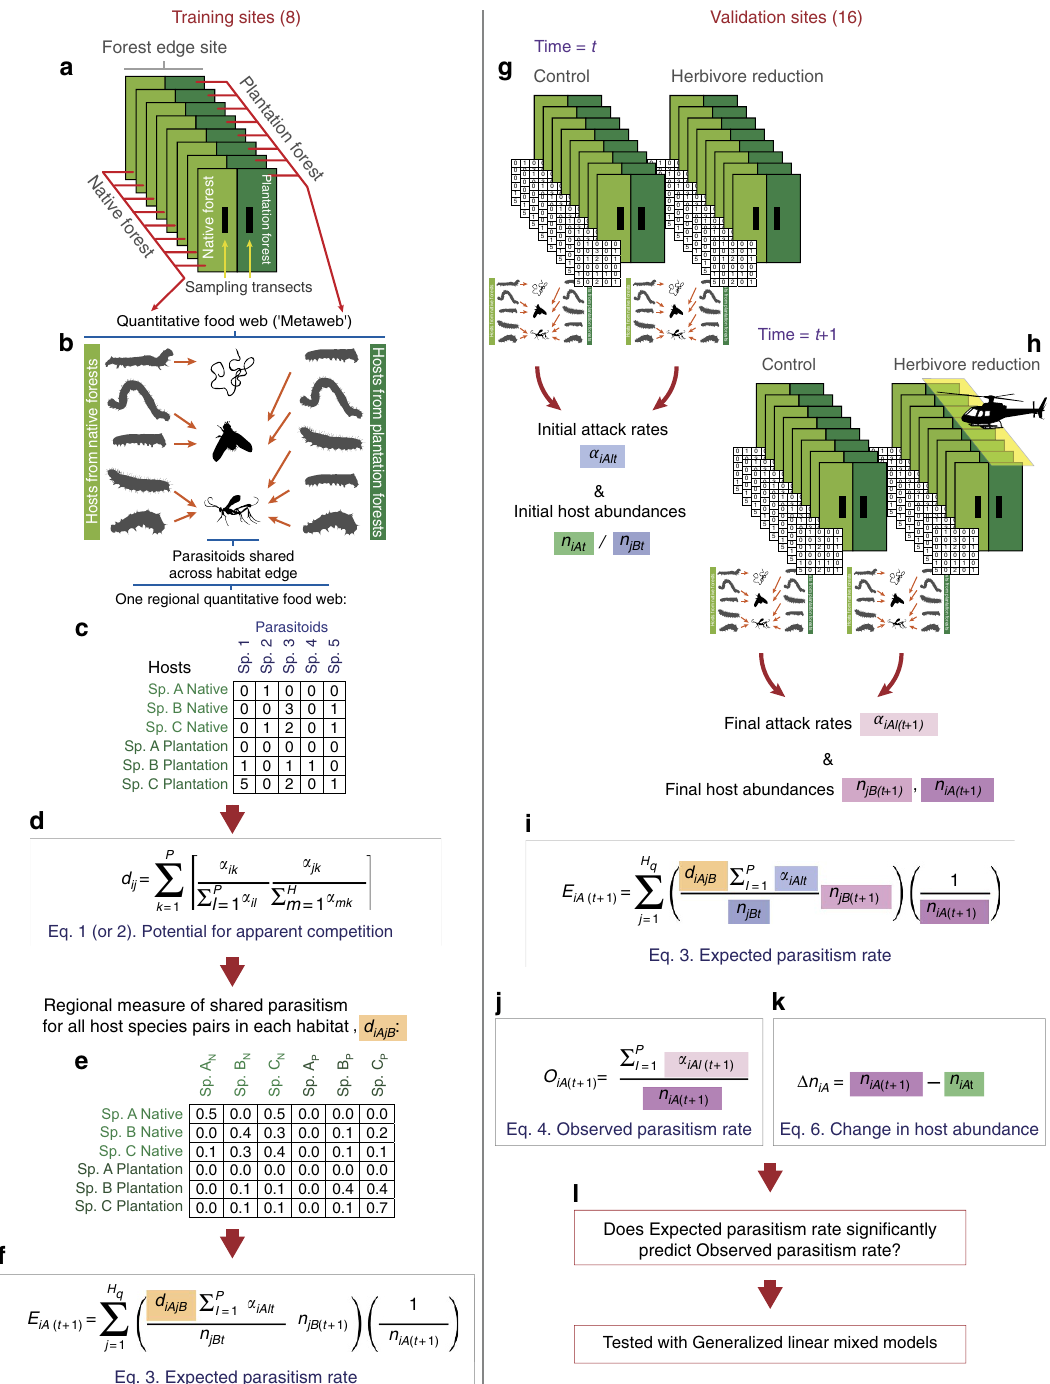
Figure 1 | Summary of methods. Sampling at training sites produced a measure of shared parasitism for each species pair among all species found in the region. ( a ) Lepidopteran larvae were collected along transects within native and plantation forest at eight forest edge sites. ( b ) Larvae were identified and reared to determine parasitism rates and parasitoid (Hymenoptera, Diptera and Nematoda) identities. ( c ) Data were pooled across sites and sampling dates, but kept separate by forest type, in order to produce one regional quantitative food web (host–parasitoid matrix), in which host habitat was explicit. ( d ) The potential for apparent competition, d iAjB , was calculated for each host pair within and across habitats. ( e ) This d iAjB value was the regional measure of shared parasitism used to calculate Expected parasitism rate in equation (3) ( f , i ). ( g ) We sampled at control and herbivore reduction validation sites at two time steps ( g , h ), before and after the aerial spray herbivore reduction treatment, which occurred between time steps ( h ). This allowed measurement of the initial attack rates and initial host abundances ( g ) and changes in host abundances ( g , h ) necessary to calculate expected parasitism rate ( i ), as well as measurement of the final attack rates and final host abundances ( h ) necessary to calculate observed parasitism rates ( j ) and change in focal host abundances ( k ). We used generalized linear mixed models to test whether Expected parasitism rate significantly predicted observed parasitism rate and change in focal host abundance ( l ) at validation sites, and thus whether apparent competition structures host–parasitoid assemblages in a predictable